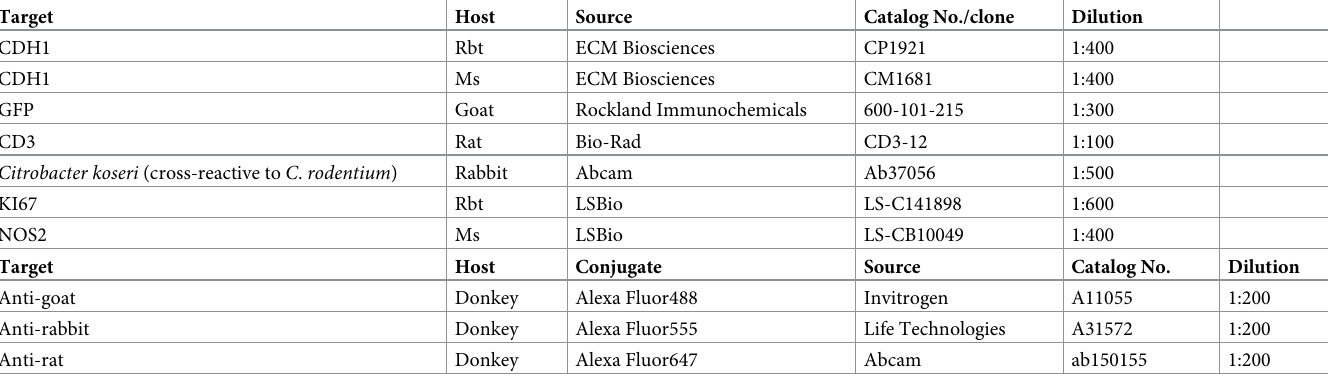
Table 1. Antibodies used for confocal